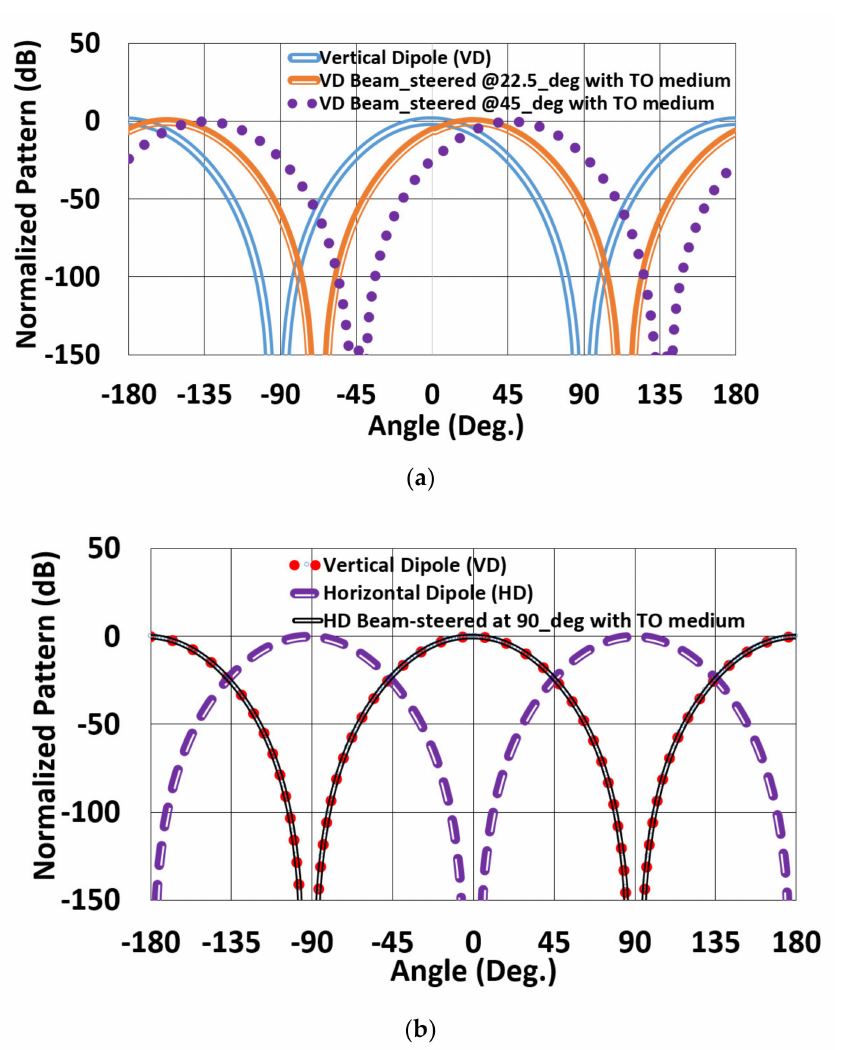
Figure 6. Far-field radiation pattern of proposed TO-based single element ( a ) beam-scheme 22.5 ◦ and φ = 45 ◦ ; ( b ) beam-steering of the horizontal dipole at φ = 90 ◦